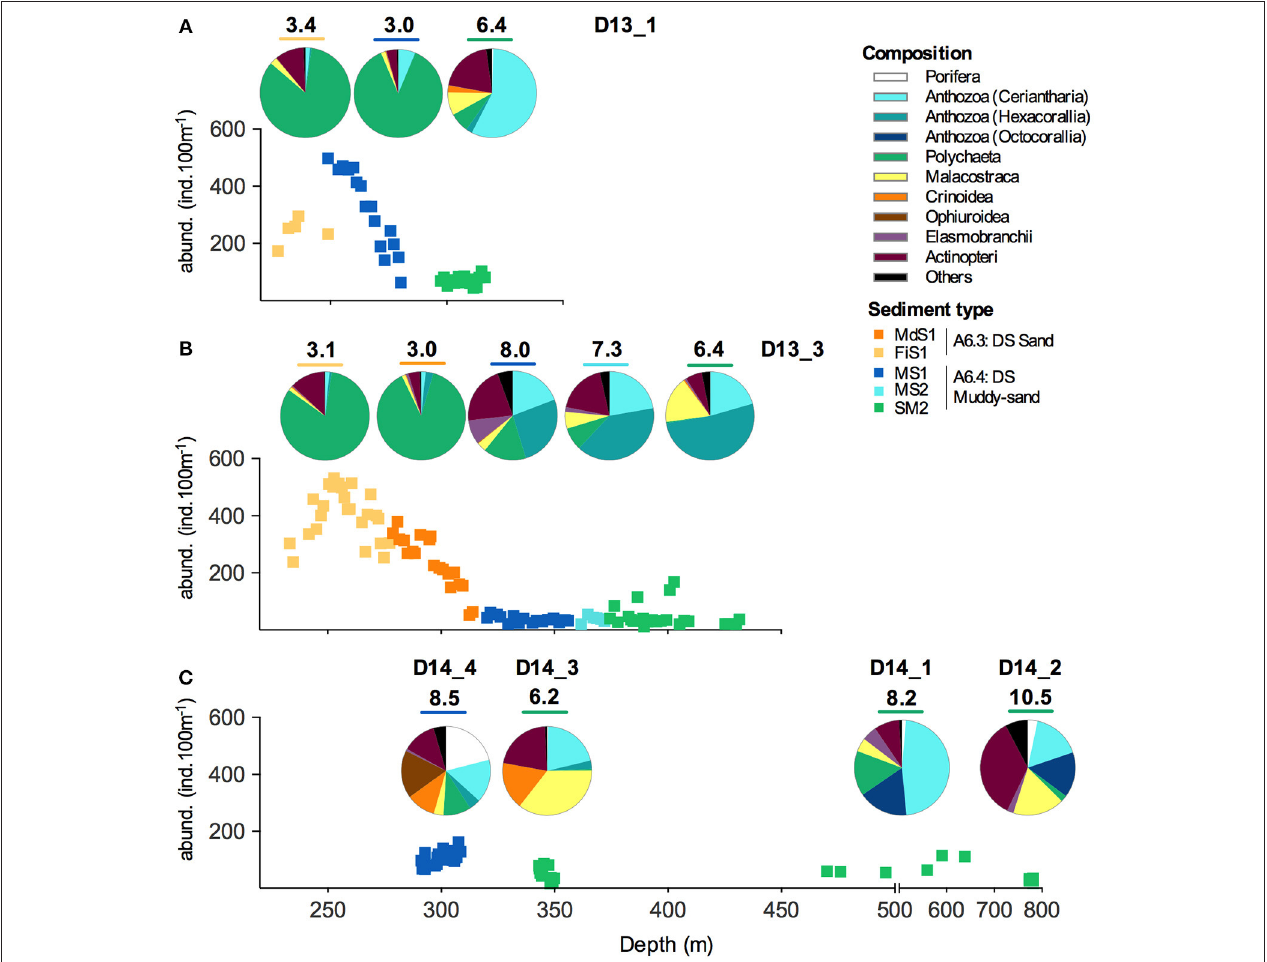
FIGURE 2 | Distribution of the mega-epibenthic fauna abundance (ind.100 m − 1 ) in relation to depth and sediment type (MdS1, medium sand; FiS1, fine sand; MS1, muddy-sand with < 30% carbonate content; MS2, muddy-sand with 30–50% carbonate content; SM2, sandy-mud). The pie charts show the taxonomic composition for each sediment type in the different dives: (A) D13_1; (B) D13_3; and (C) all 2014 dives. Hulbert’s expected number of taxa [ET (20) ] for each assemblage is indicated above the respective pie charts. “Others” represent all the taxa that contribute with < 1% to the total